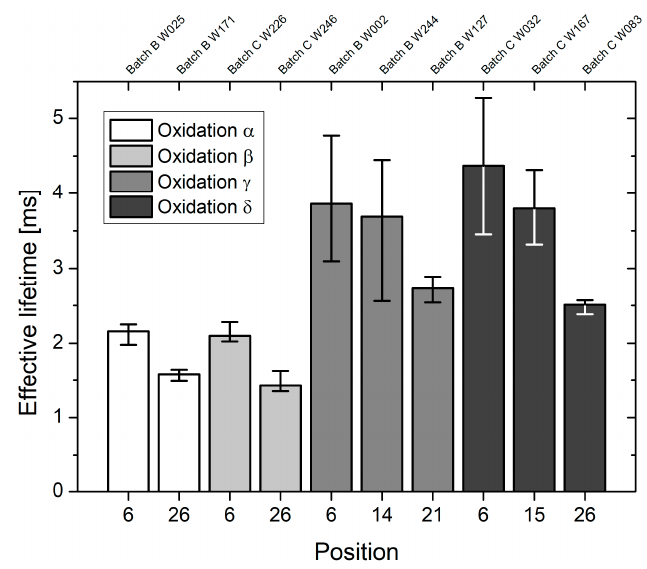
Figure 3. For oxidation runs α , β , γ and δ , respectively, the effective lifetime (median value, 25–75% quantile) is shown as a function of the quartz boat position and wafer number. While oxidation runs α and γ only contained 150 mm wafers from batch B, oxidation runs β and δ only contained 100 mm wafers from batch C. Quartz boat positions 21 and 26, respectively, are located in direction of the tube door.